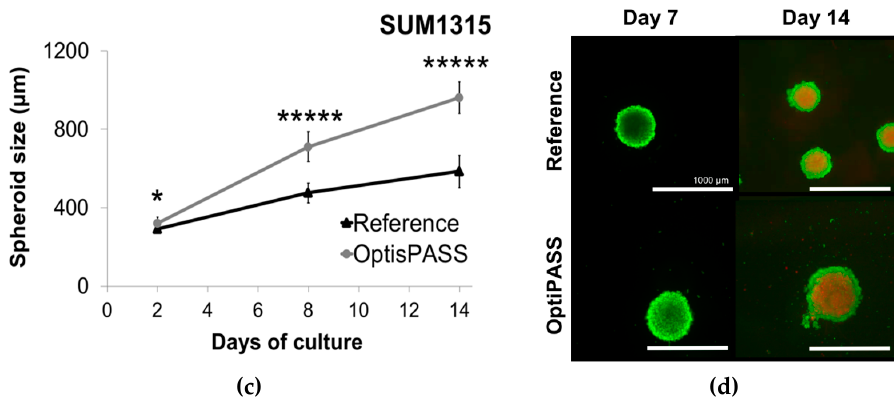
Figure 3. MDA-MB-231 ( a , b ) and SUM1315 ( c , d ) spheroid development with OptiPASS medium. ( a , c ) Spheroid size monitoring: spheroids formed with reference and OptiPASS medium were imaged